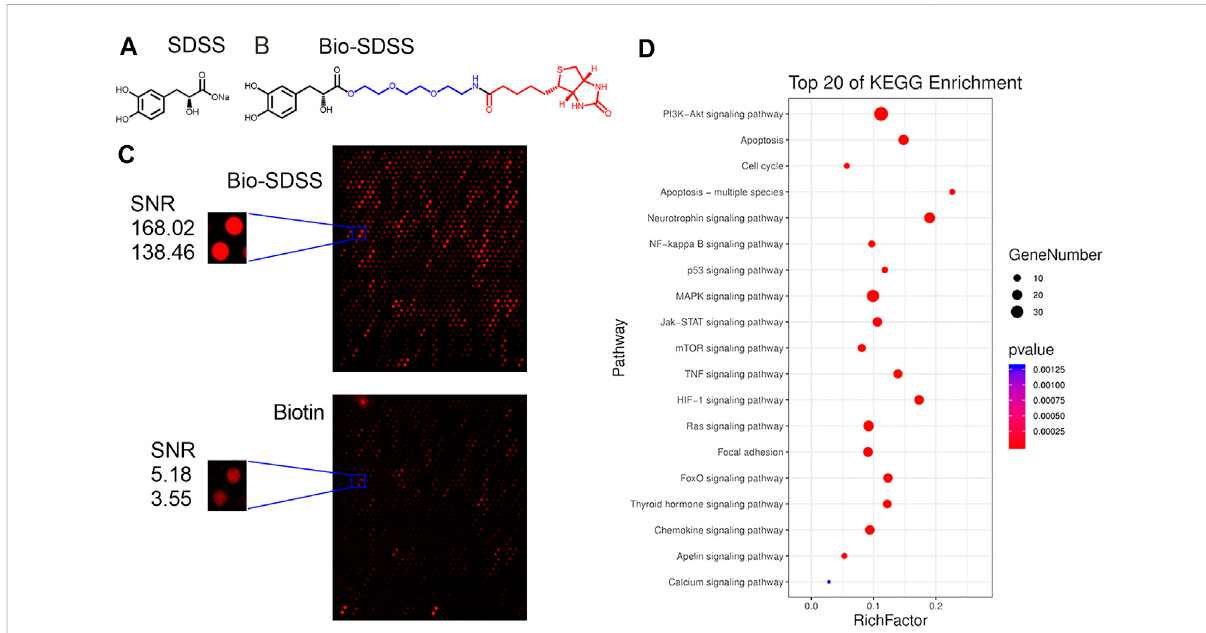
FIGURE 2 Identi fi cation of SDSS binding proteins. (A) The chemical structure of SDSS and (B) biotin-labeled SDSS (Bio-SDSS). The blue color represents polyethylene glycol (PEG) ligand and the red color represents biotin. (C) Representative image of protein array, including positive control spots (Bio- SDSS) and negative control spots (biotin), as well as the magni fi ed image of bio-SDSS binding to AKT1. The signal-to-noise ratio (SNR) is shown. (D) The top 20 KEGG enrichment results for SDSS-related targets based on network